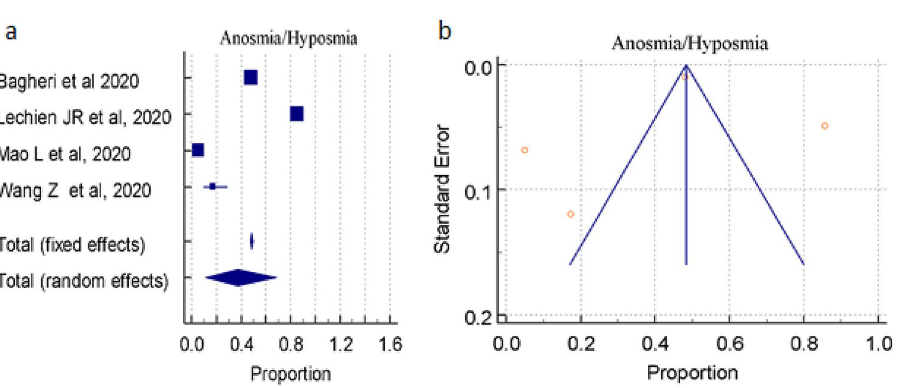
Figure 5. ( a ) Forest plot showed pooled prevalence of anosmia/hyposmia complications among patients with COVID-19. ( b ) Funnel plot showed publication bias among studies evaluating neurological complications of COVID-19.